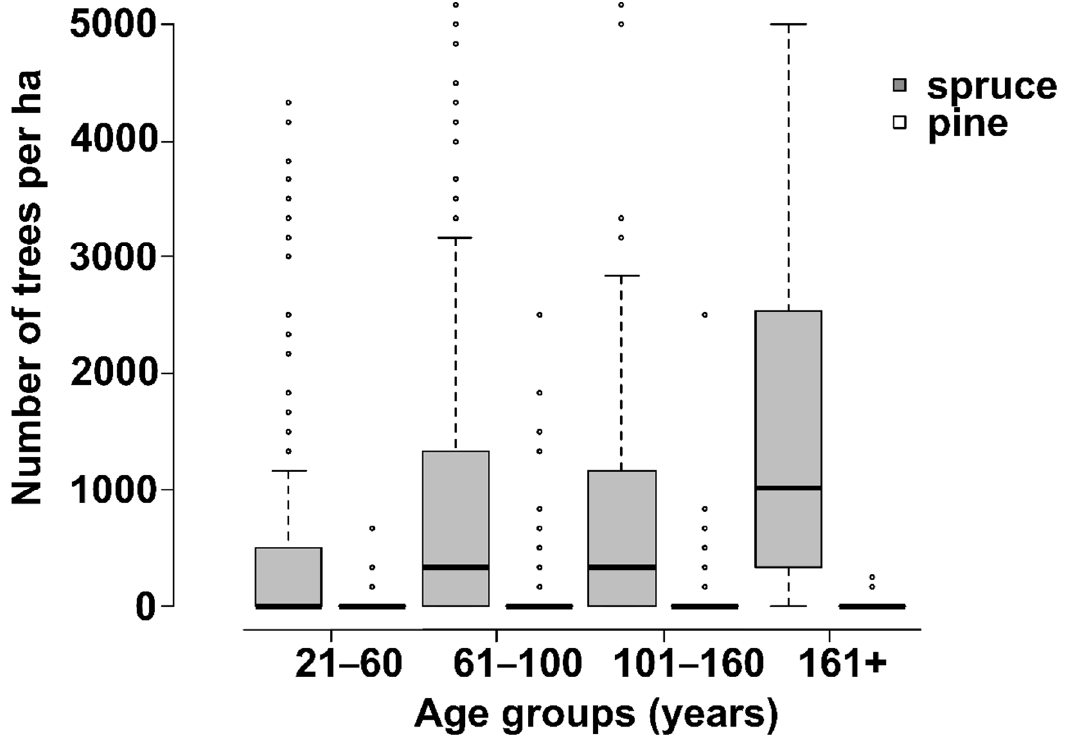
Figure 3. The density of advance regeneration of Norway spruce and Scots pine in different stand age groups.